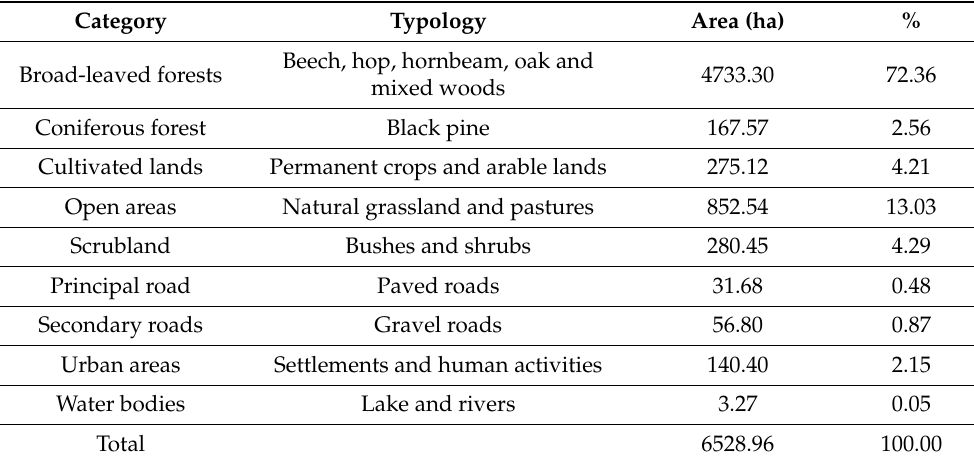
Figure 4. Representation of the minimum convex polygon (MCP) of the female wolf nicknamed Carlina generated starting from the GPS locations (Fix Carlina) recorded in the period between 1 August and 26 November 2013 (MCP overall). Table 2. Land covers of the overall minimum convex polygon (MCP).